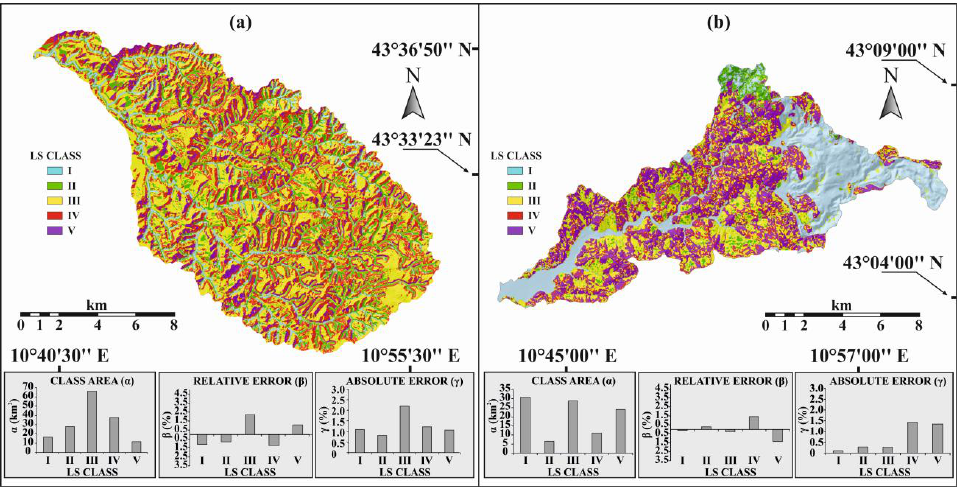
Figure 6. The best models of the Roglio ( a ) and Milia ( b ) basins. Landslide susceptibility class area, relative error and absolute error distributions are reported.